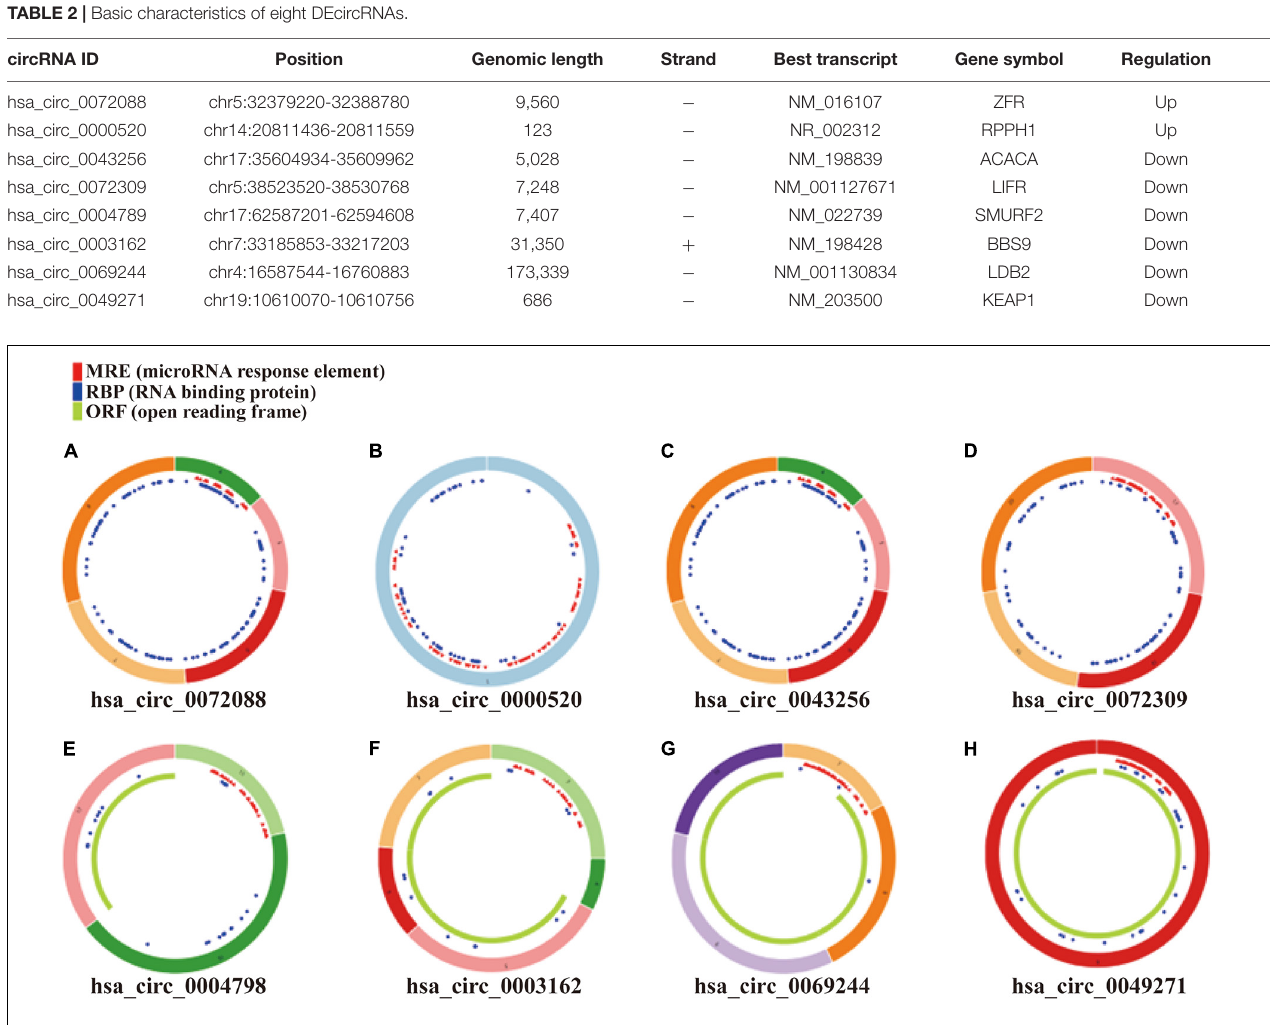
FIGURE 3 | Structural patterns of eight DEcircRNAs. (A) hsa_circ_0072088, (B) hsa_circ_0000520, (C) hsa_circ_0043256, (D) hsa_circ_0072309, (E) hsa_circ_0004789, (F) hsa_circ_0003162, (G) hsa_circ_0069244, and (H)